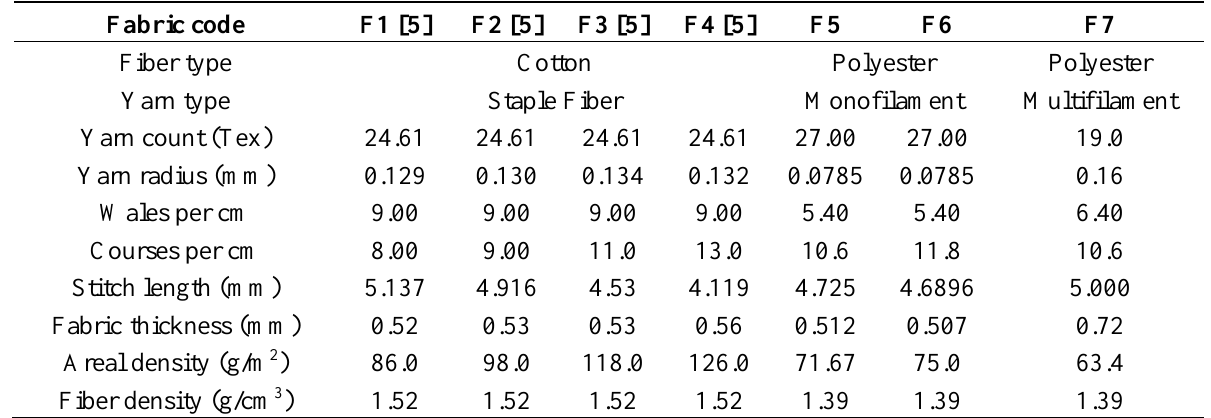
Table 1. Specifications of plain weft knitted